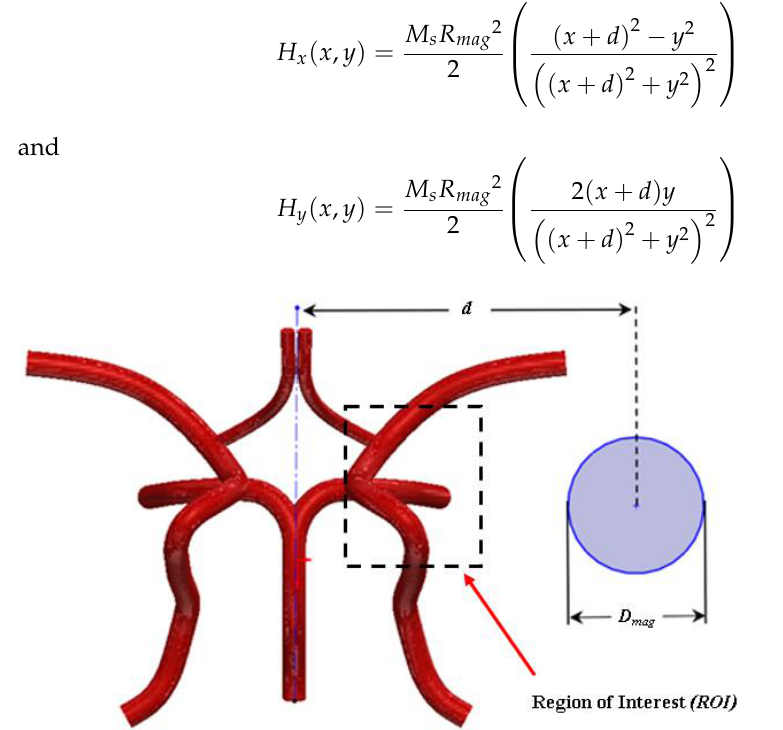
Figure 16. Schematic representation of the circular electromagnet of radius “ R mag ” distanced “ d ” from the centroid of the CoW arterial model and the ROI site.